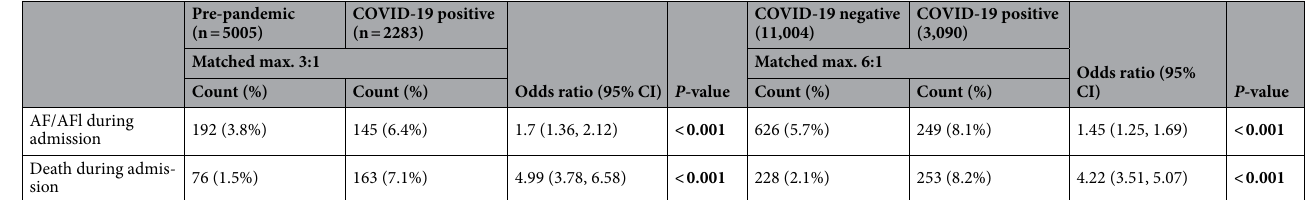
Table 2. Matched patient outcomes. AF atrial fibrillation, AFl atrial flutter. Significant values are in